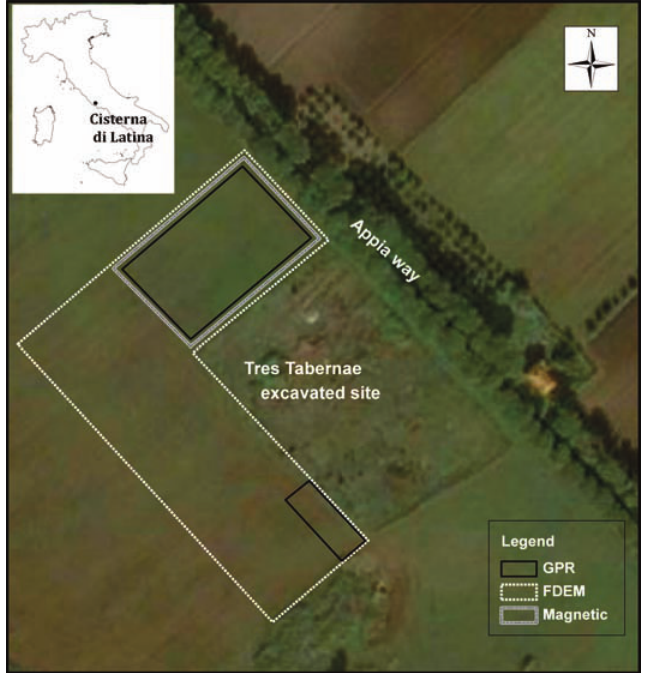
Figure 1. Map of the Tres Tabernae statio and the location (inset) of the areas investigated by these geophysical techniques (photograph from Google